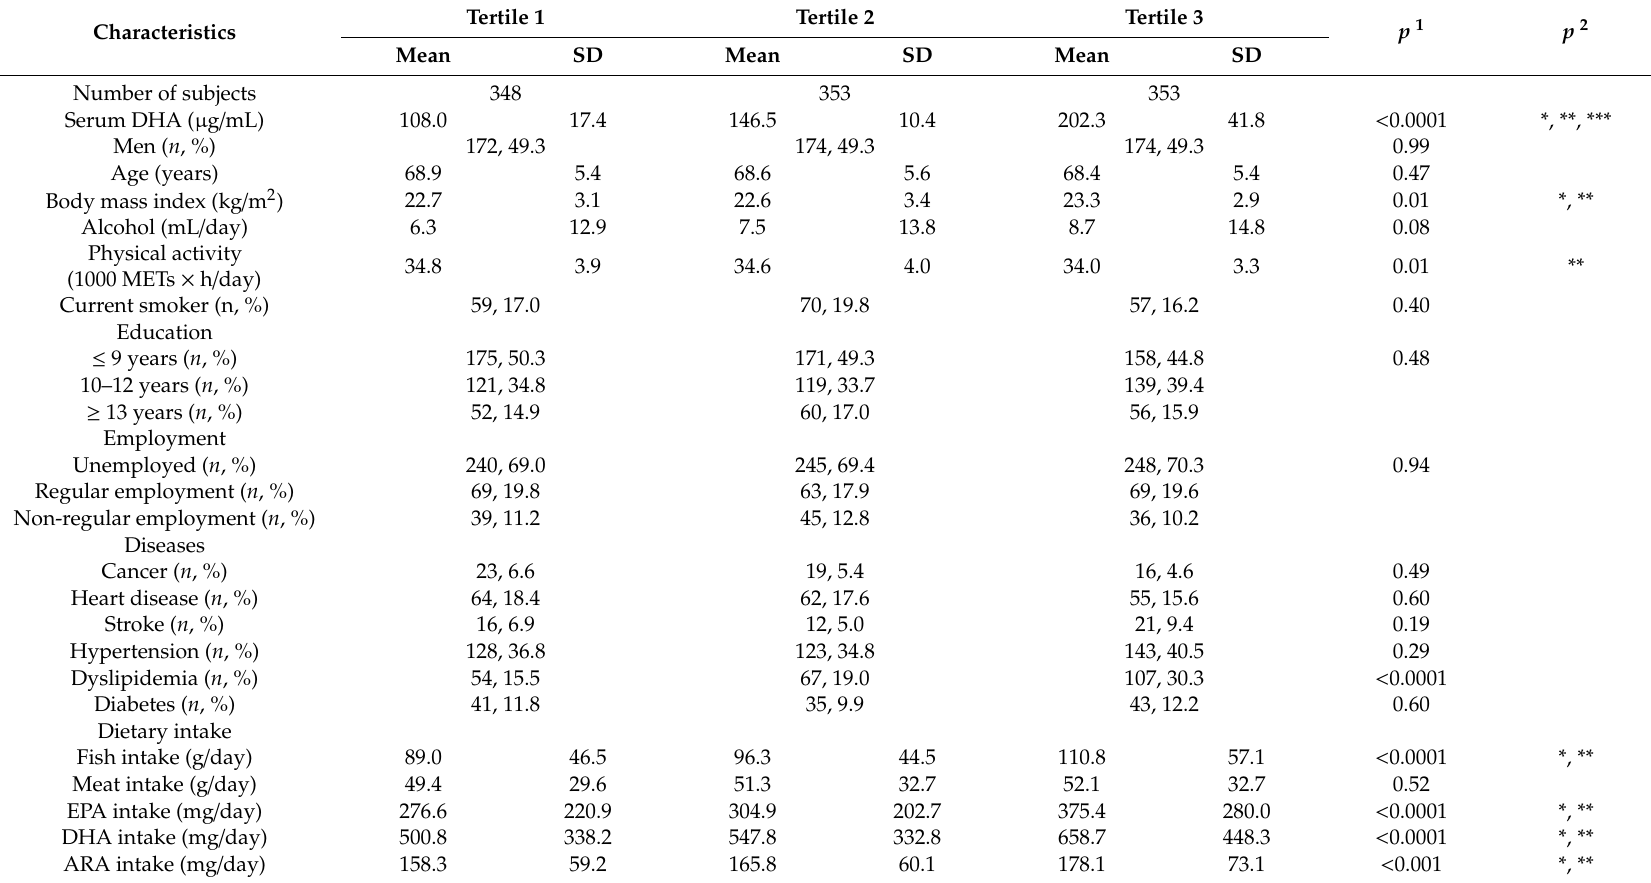
Table 4. Baseline characteristics of participants by tertiles of serum DHA ( n =